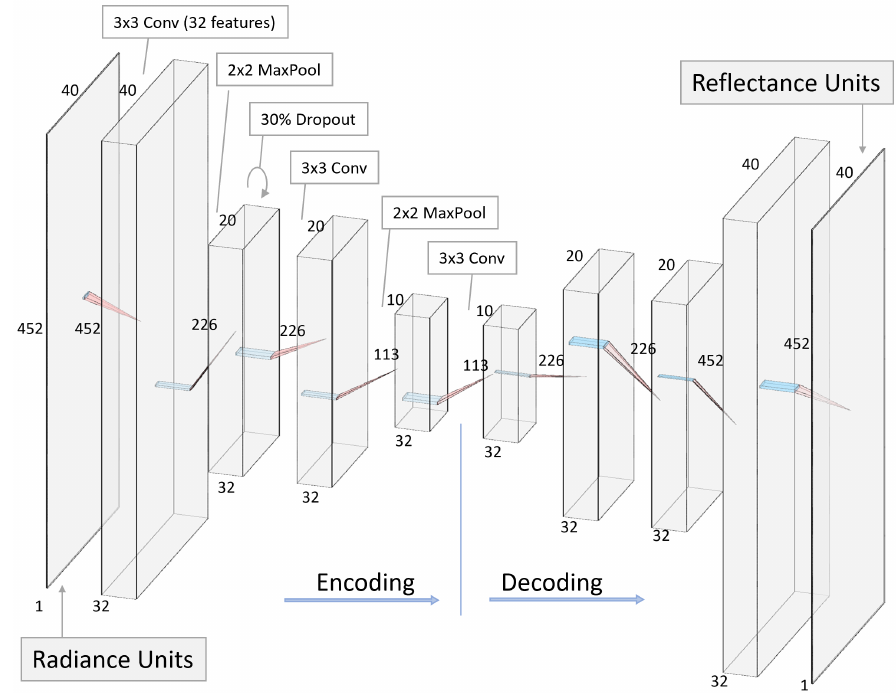
Figure 9. The autoencoder neural network used for converting from radiance to reflectance. Details for the network architecture are included in the